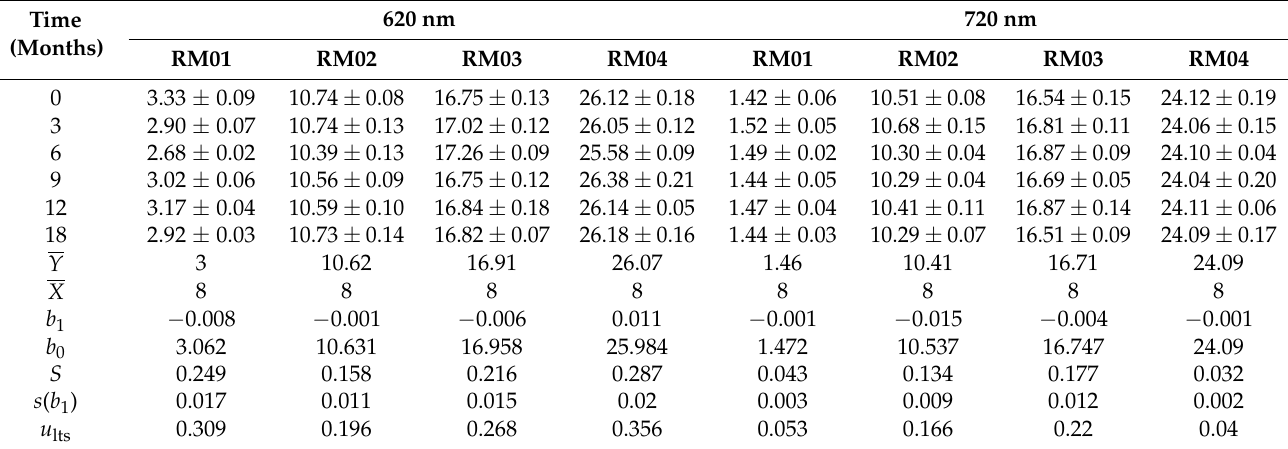
Table 2. Analyses of long-term stability of AAC of the four rice reference materials (0–4 ◦ C) a